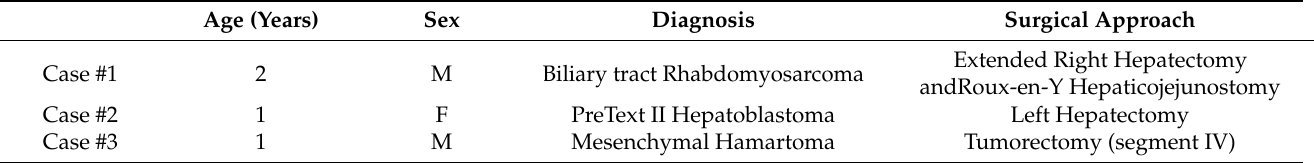
Table 4 summarises the patients’ information. Table 4. Patients’